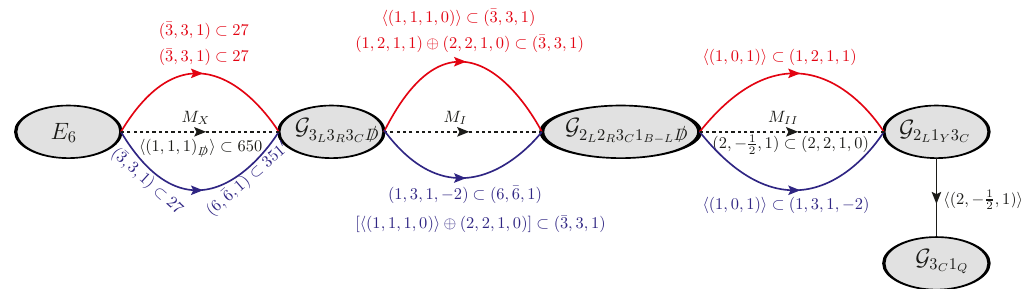
Figure 2. E 6 breaking to the SM with two intermediate steps. The VEVs and the Higgs fields contributing to the RGEs at each stage are indicated. The upper (red) arrows correspond to the model in section 3.3, and the lower (blue) arrows correspond to the model in section 3.4. The dashed arrows in the middle are common to both